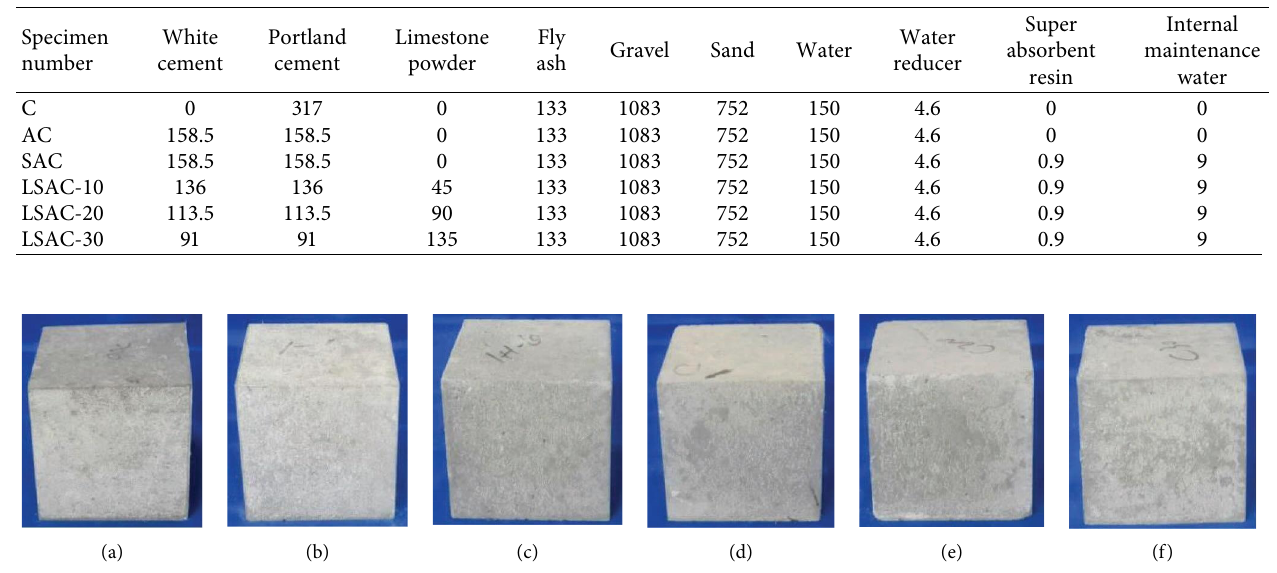
Figure 1: Appearance of fair-faced concrete. (a) C. (b) AC. (c) SAC. (d) LSAC-10. (e) LSAC-20. (f)